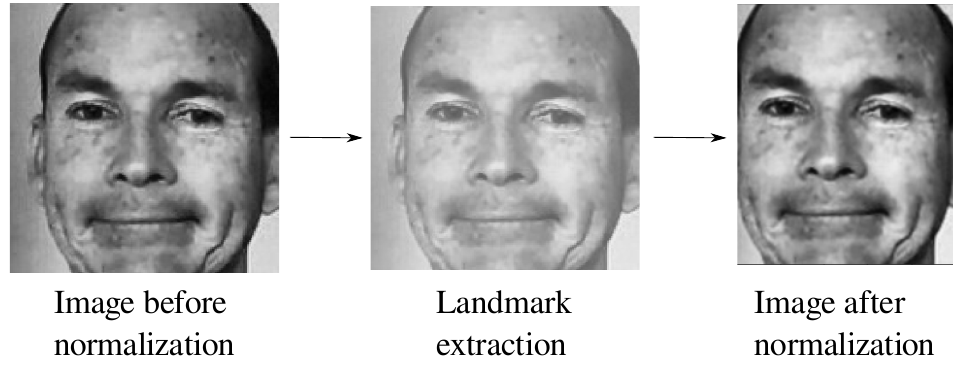
Figure 2. Normalization process using